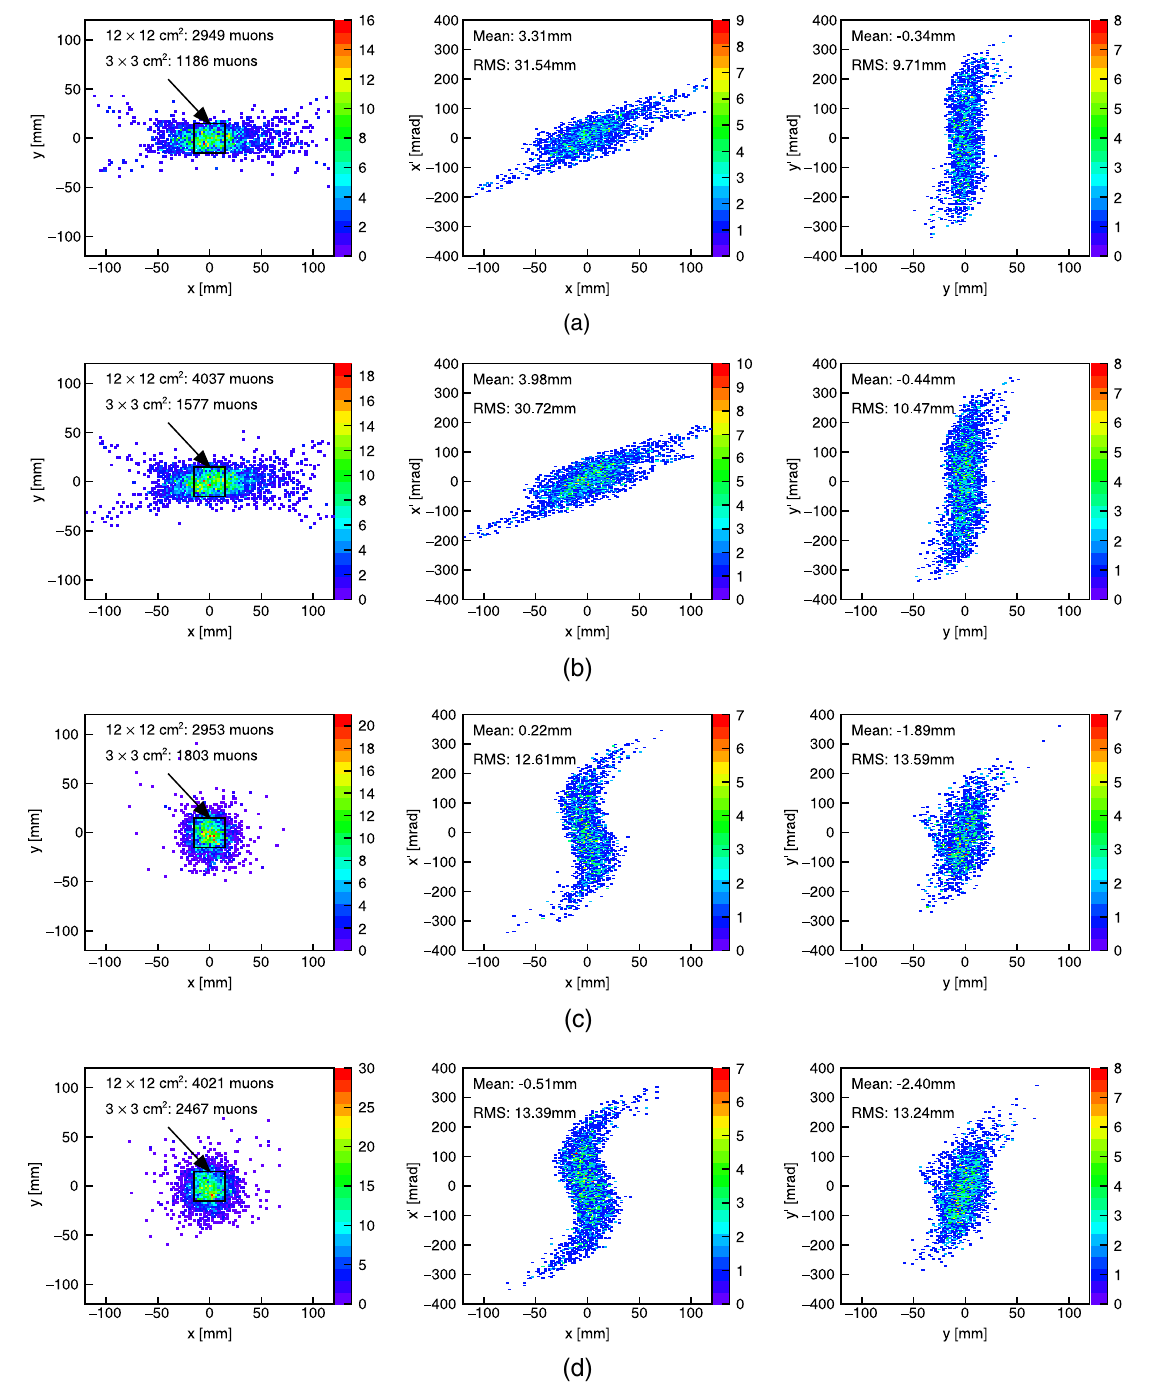
FIG. 8. Simulated beam spots and phase spaces at the LEM moderator position for different muon target E geometries and beamline settings: (a) OTE þ quadrupole triplet (i.e., the original setting of the μ E 4 ); (b) NTE þ quadrupole triplet; (c) OTE þ G4beamline solenoid WSY; (d) NTE þ G4beamline solenoid WSY. For the NTE simulation, the center of the μ E 4 beamline is aligned to the center of the muon distribution [ x ¼ − 8 mm in Fig.